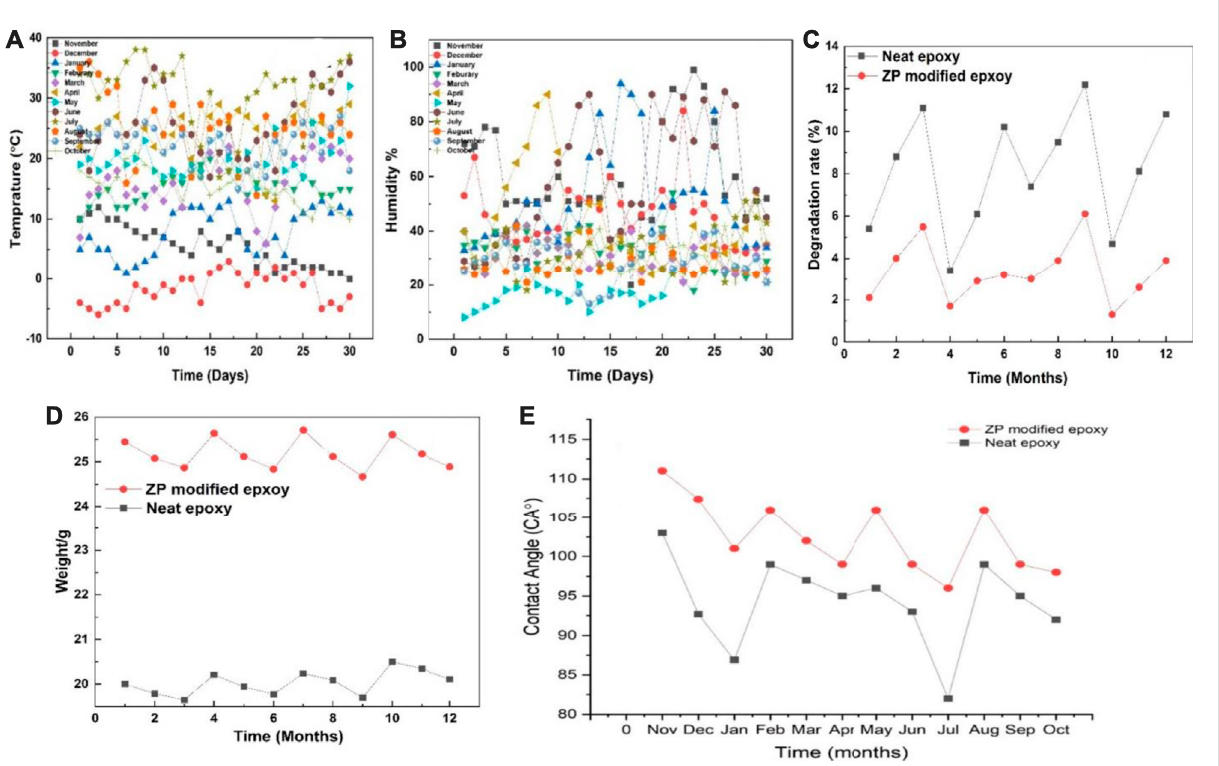
FIGURE 5 (A, B) Changes of temperature and humidity data in Xi ’ an, China, 5 (C, D) Degradation of coating of neat epoxy and ZP pigments modi fi ed epoxy peeling-off force and scratch visible weight, while 5 (E) showing contact angles of the neat and ZP modi fi ed coating ’ s degradation throughout the year.